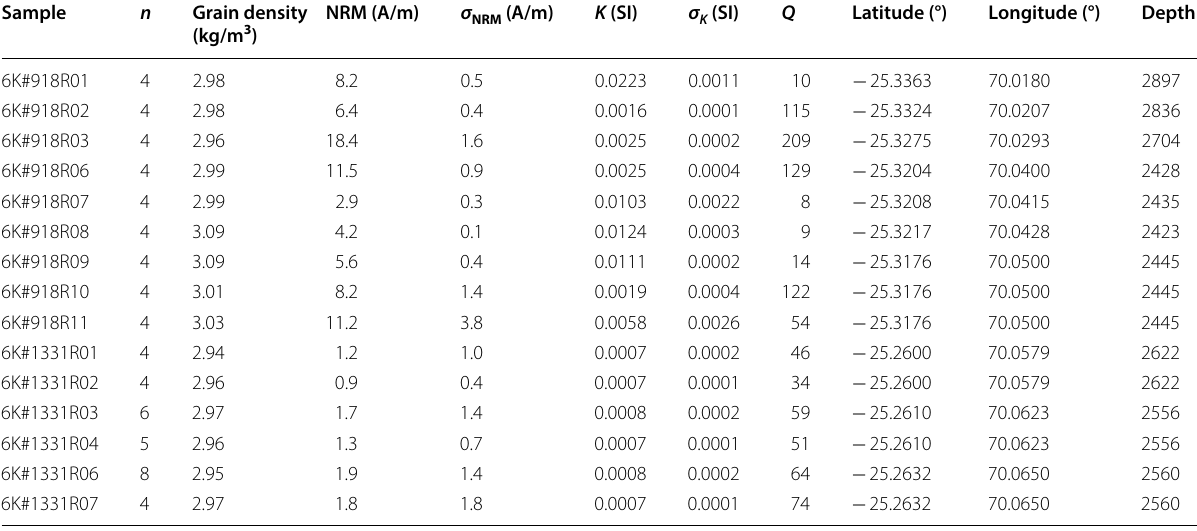
Table 1 Rock magnetic and physical properties. Bulk grain density, natural remanent magnetization (NRM), magnetic